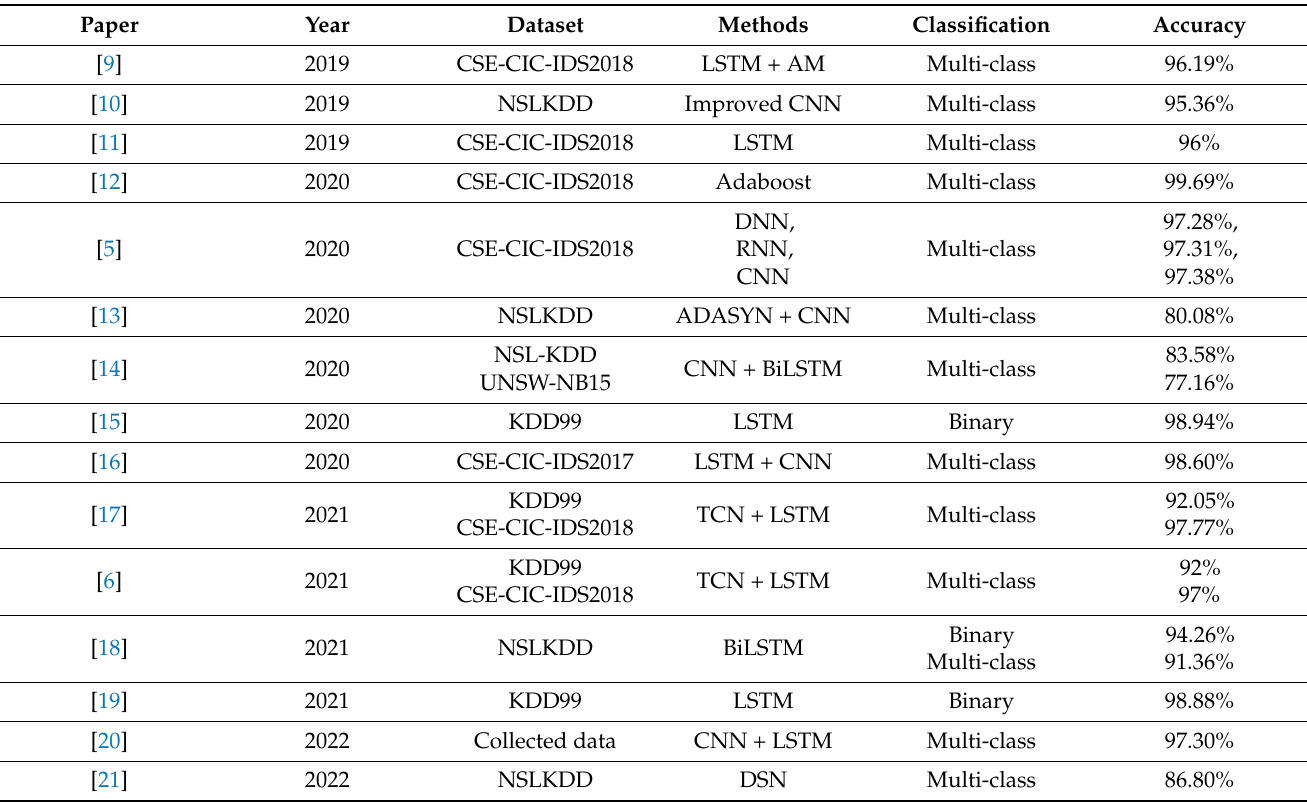
Table 1. Summary of recent